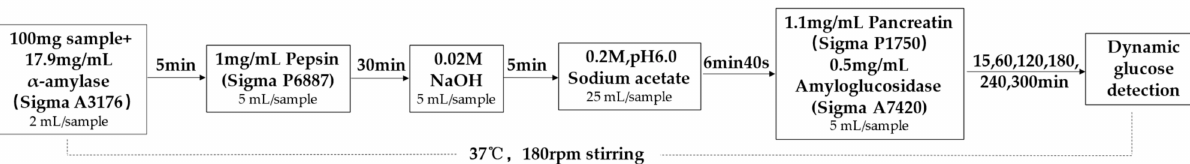
Figure 1. The flow chart of digestion method of GI20